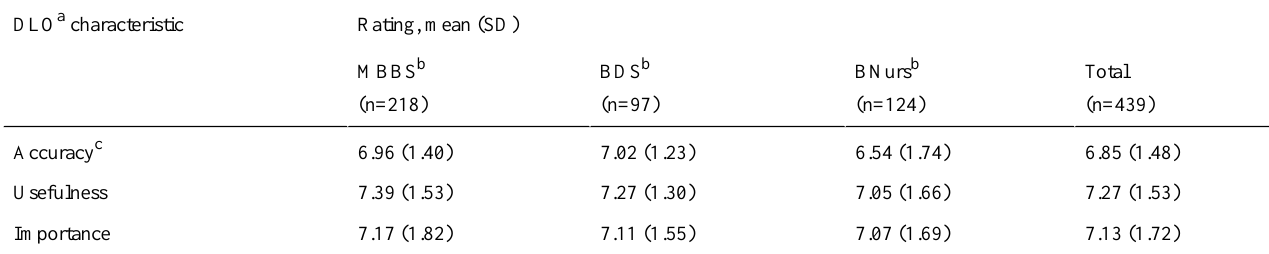
Table 5. Rating of Internet digital learning objects.